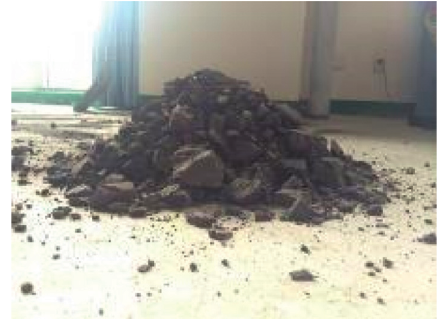
Figure 7: Test of the natural testing angle.